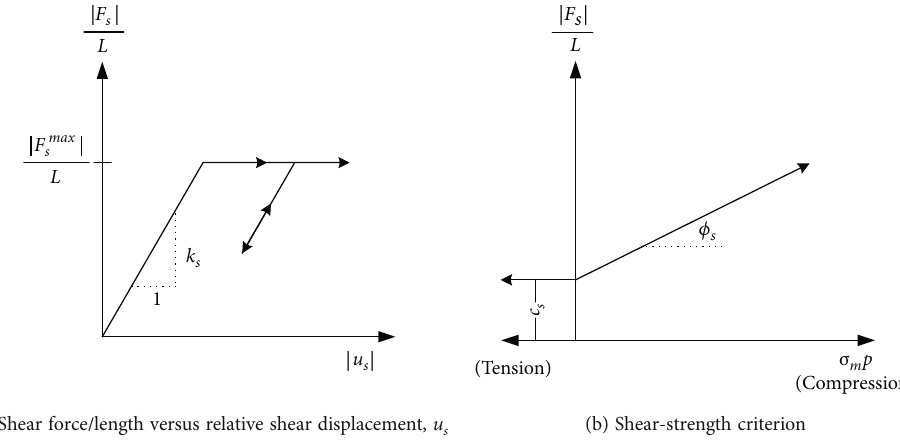
Figure 3: Behavior of shear coupling springs of PILE element